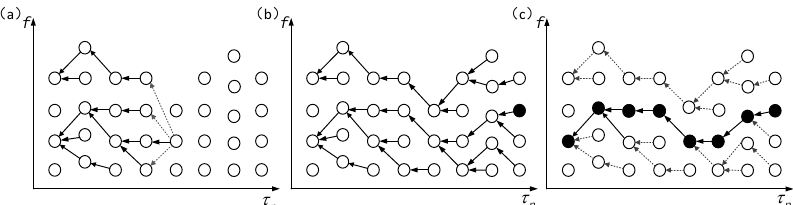
Figure 1. Illustration of fast path optimization (FPO): ( a ) amplitude peaks, ( b ) all possible paths, ( c ) the optimization path (reprinted from ref. [26]).